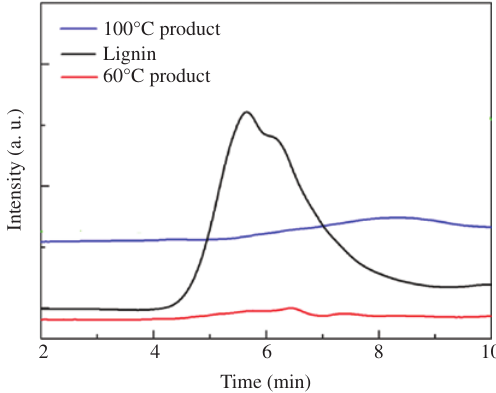
Figure 6: GPC curves of lignin and degraded